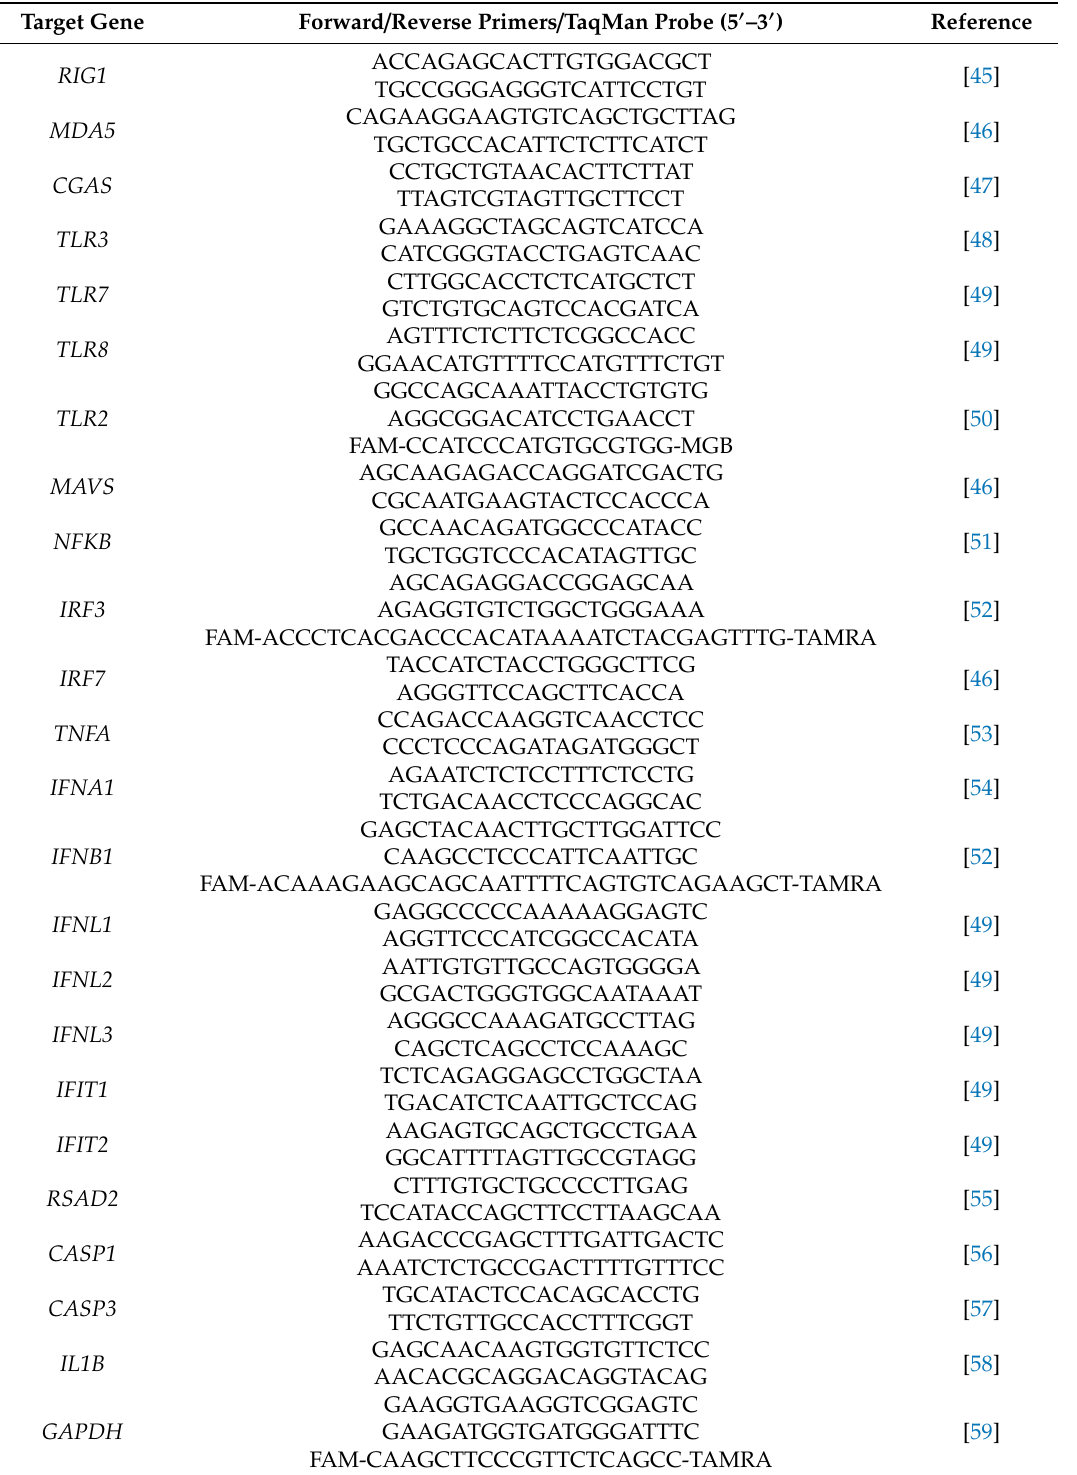
Table 2. Primers and probes used for qRT-PCR analysis mRNA levels of genes involved in innate antiviral